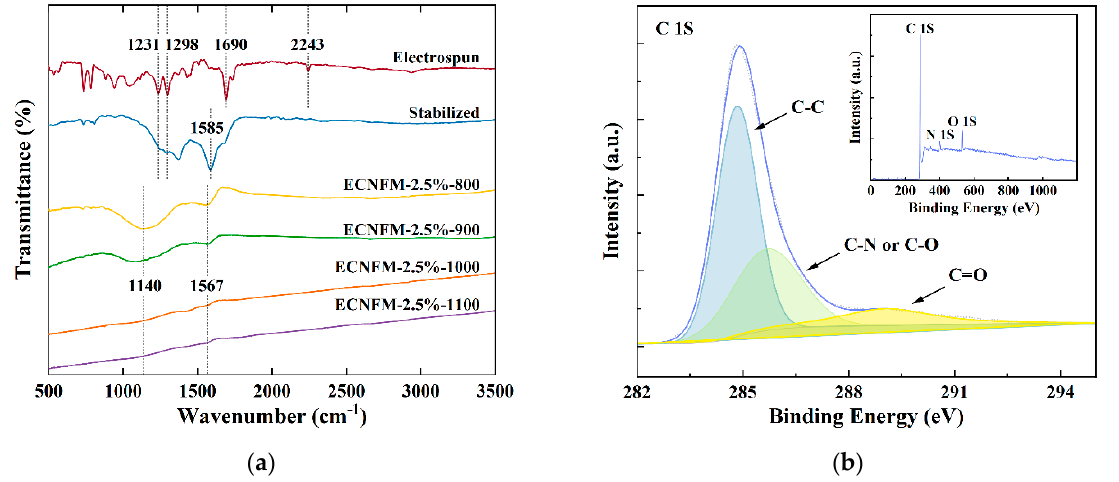
Figure 4. ( a ) FTIR spectra of ECNFM-2.5%-T (T = 800, 900, 1000, 1100 °C); ( b ) high-resolution of C 1s spectrum (inset panel: full survey scan) of ECNFM-2.5%-1000.